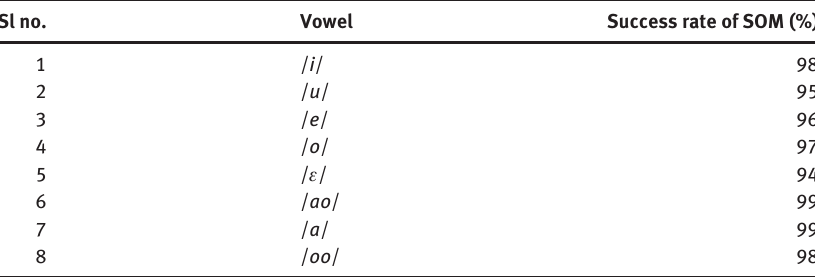
Table 5. SOM Segmentation Success Rate.